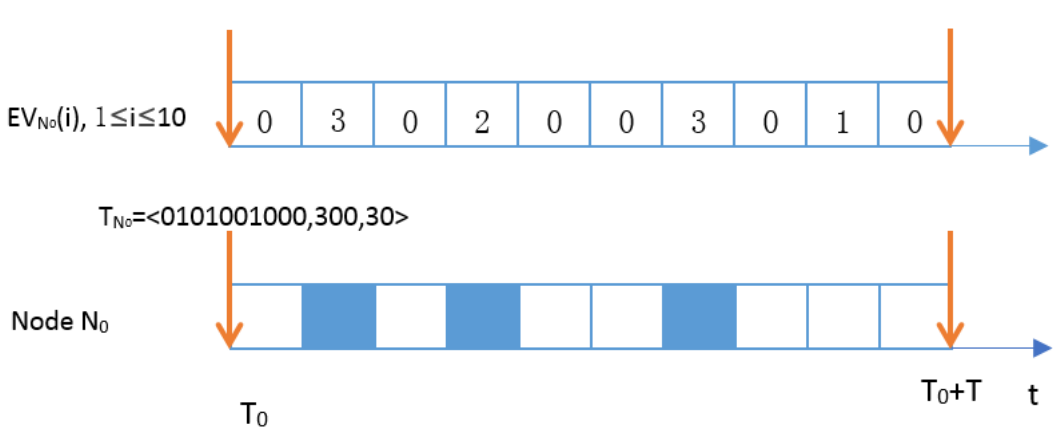
Figure 4. An example of the Adaptive Scheduling Mechanism based on Self-Similarity ( ASMSS